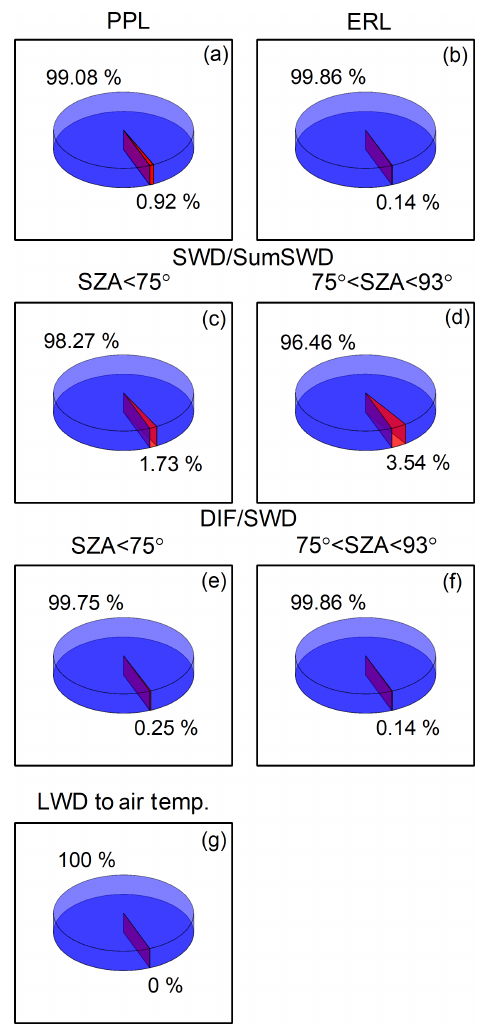
Figure 9. Percentage of rejected data (red color) and accepted data (blue color) according to the PPLs and ERLs, and comparison of various irradiance components (SWD, SumSWD, DIF, LWD and air temperature) at IZA between 2009 and